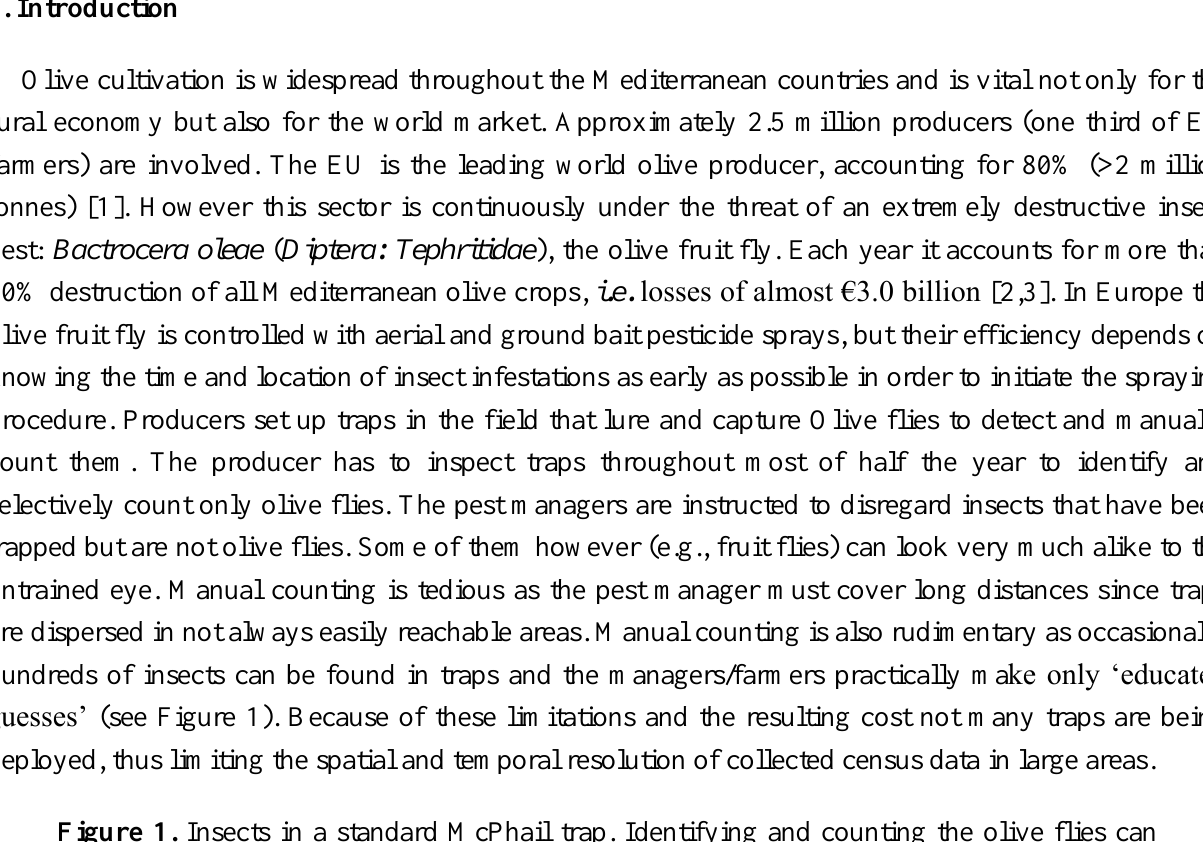
Figure 1. Insects in a standard McPhail trap. Identifying and counting the olive flies can be